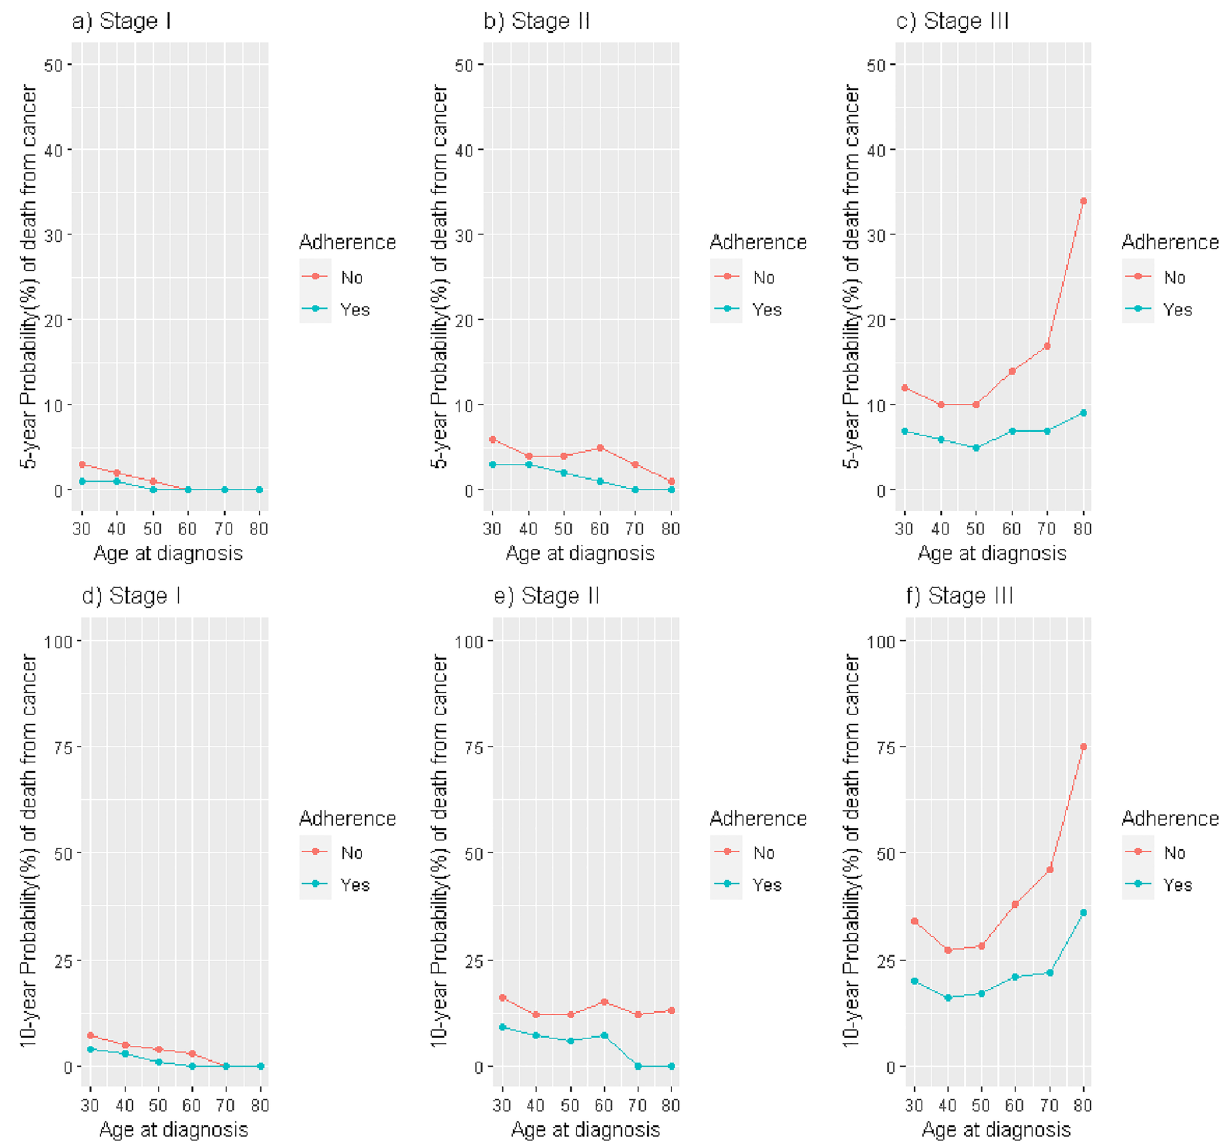
Figure 3. Predicted cumulative probabilities of death due to cancer at 5 (panels a – c ) and 10 years (panels d – f ) after diagnosis according to age and adherence to treatment (results presented by stage of BC at